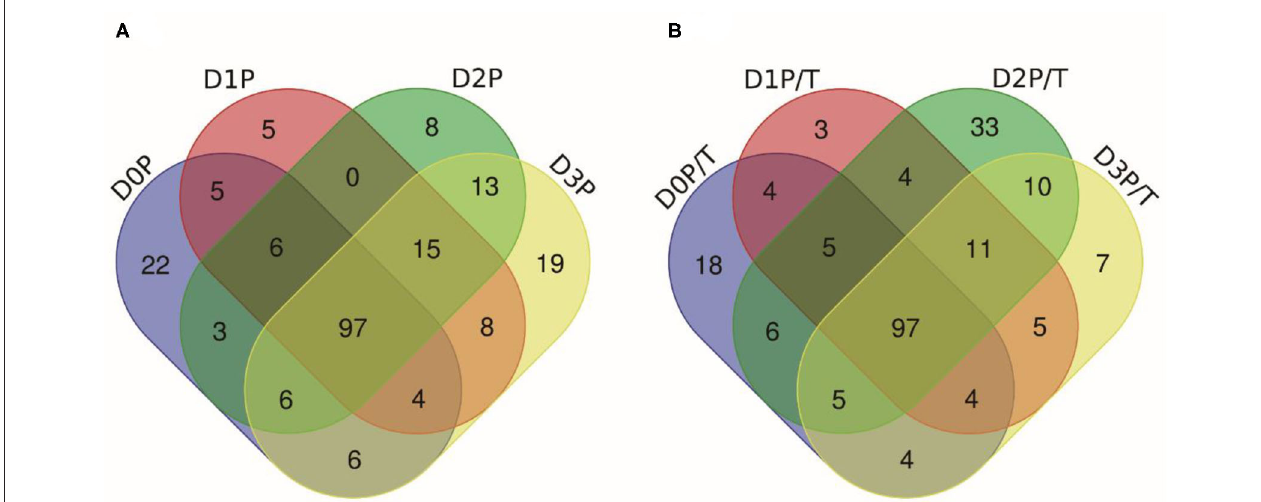
FIGURE 4 | The numbers of unique peptides after pepsin and trypsin treatments. (A) D0P, D1P, D2P, and D3P represent 0, 1, 2, and 3 d pepsin treated samples, respectively; (B) D0P/T, D1P/T, D2P/T, and D3P/T represent 0, 1, 2, and 3 d pepsin and trypsin treated samples, respectively.